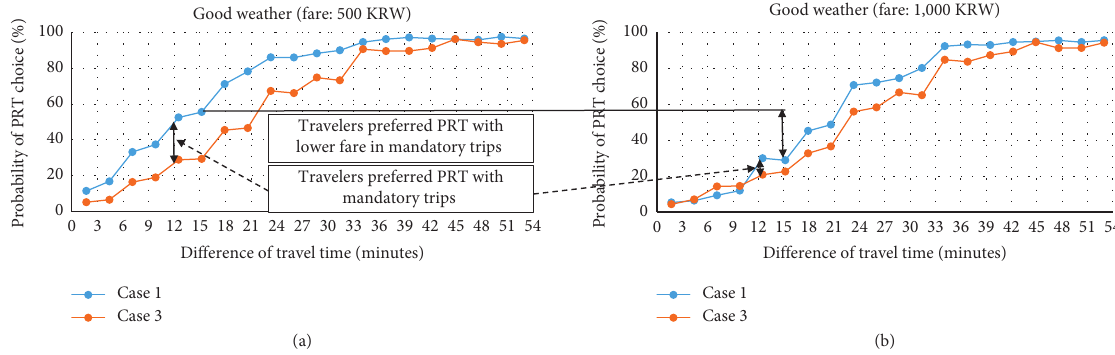
Figure 9: Impacts by fare and trip purpose on PRT choice under good weather conditions.